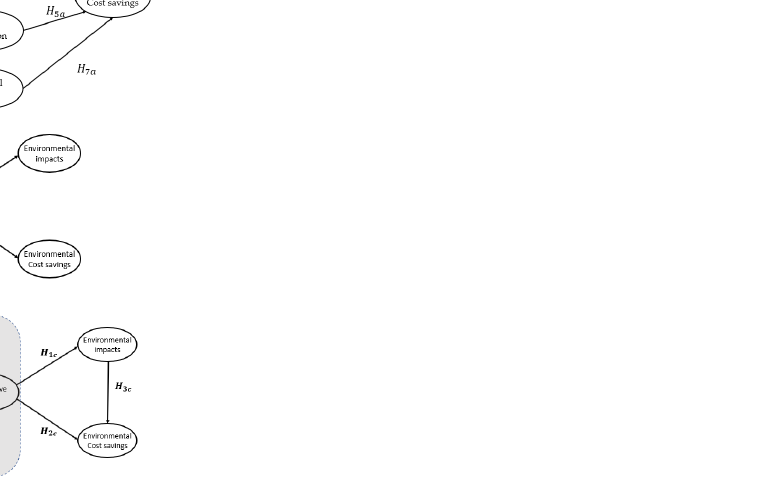
Figure 1. Proposed hypotheses. ( a ) Simple model; ( b ) Second order model; ( c ) Mediator model.